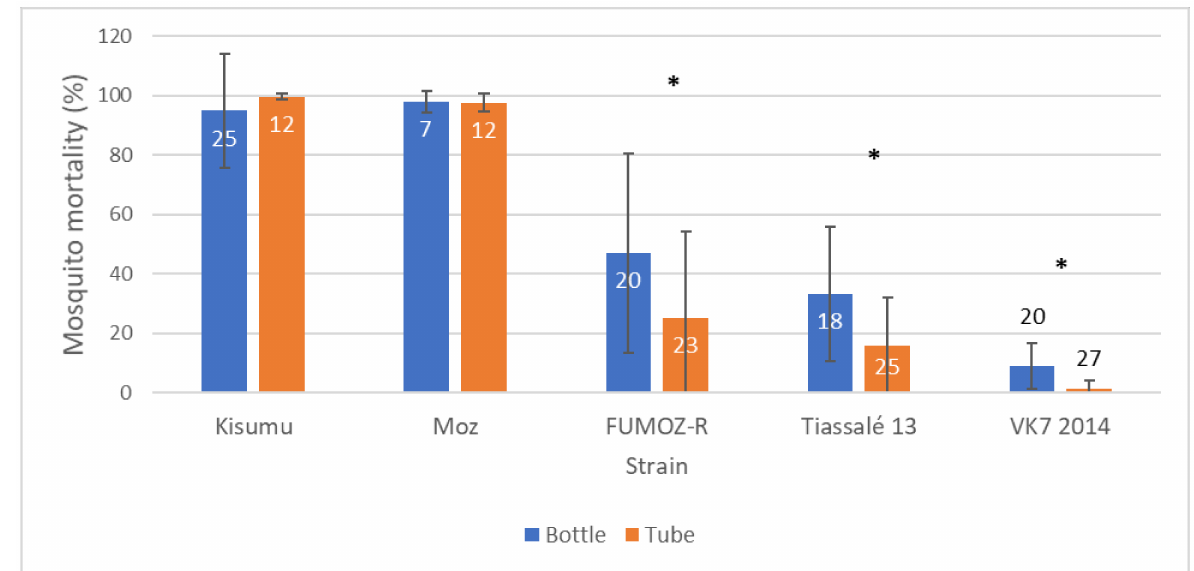
Figure 6. Average mosquito mortality following exposure to discriminating doses of permethrin in CDC bottles (0.00125 µ g/bottle) (blue bars) or WHO tube (0.75%) bioassays (orange bars) in LITE strains. Numbers above or in bars indicate the number of replicate bottles or tubes. Error bars show the standard deviation to indicate variability between replicates. Asterisks above bars indicate where mean mortalities were significantly different ( p < 0.05, Welch’s t